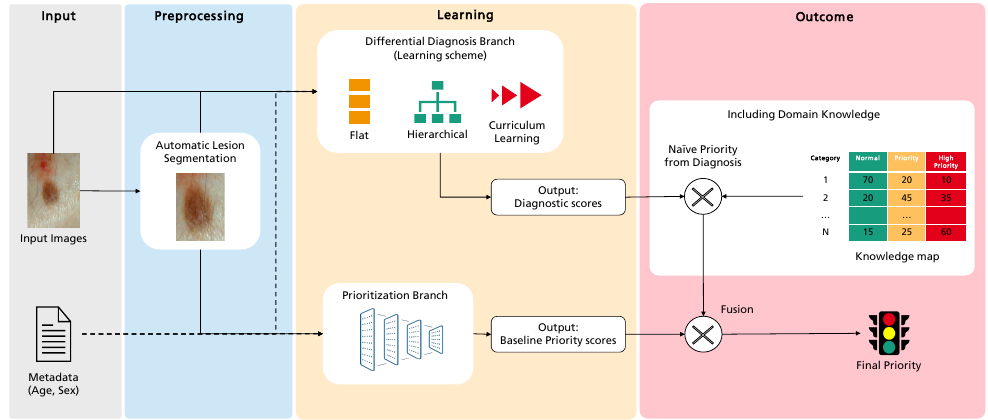
Figure 1. Overview of the methodology followed in this work towards the prediction of dermatologi- cal case risk